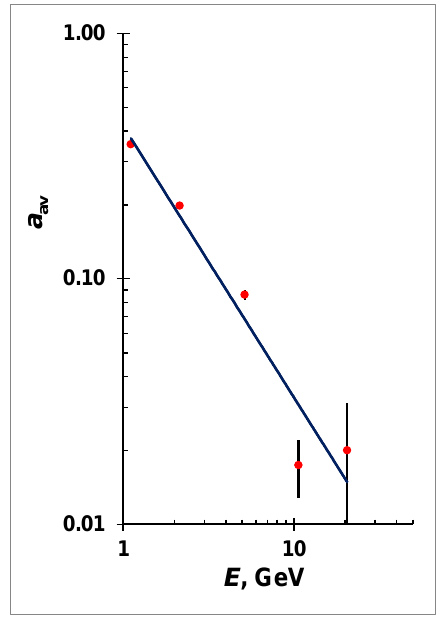
Figure 7. The energy dependence of a av ( E ): a av ( E ) = 0.42 E − 1. When the value of a av ( E ) is near zero (rather small), this means that the drift currents of particles are near zero and also, according to modern ideas, the plateau in time